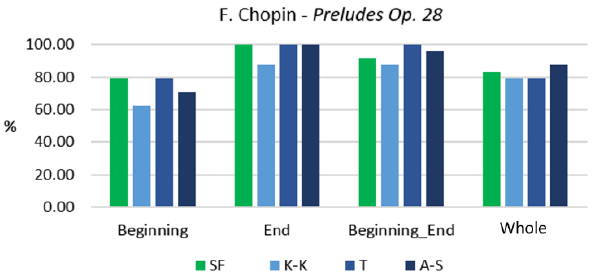
Figure 12. The key-finding efficacies obtained for the Preludes Op. 28 by F. Chopin; the samples represented with the aggregate durations of individual pitch-classes.